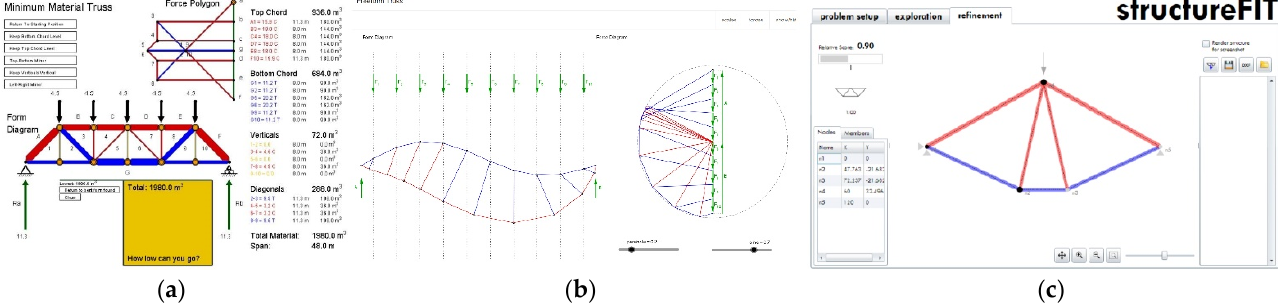
Figure 1. Examples of supporting graphic statics computer applications: ( a ) Active Statics; ( b ) eQuilibrium; ( c ) structure- FIT.